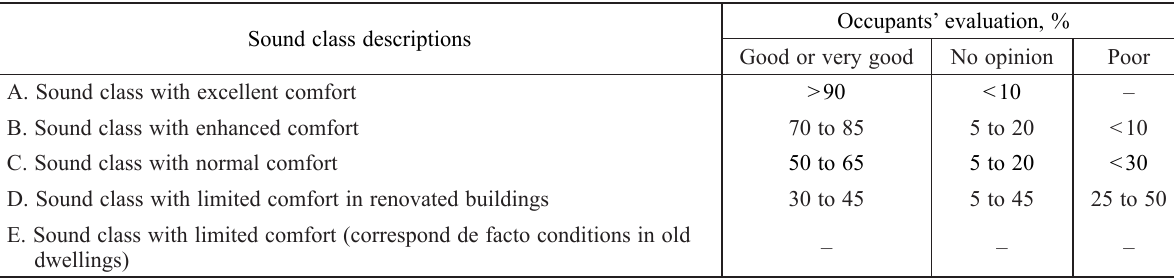
Table 2. Rating values of subjective questioning in case of 5 sound classes for dwellings (adopted to Lithuania